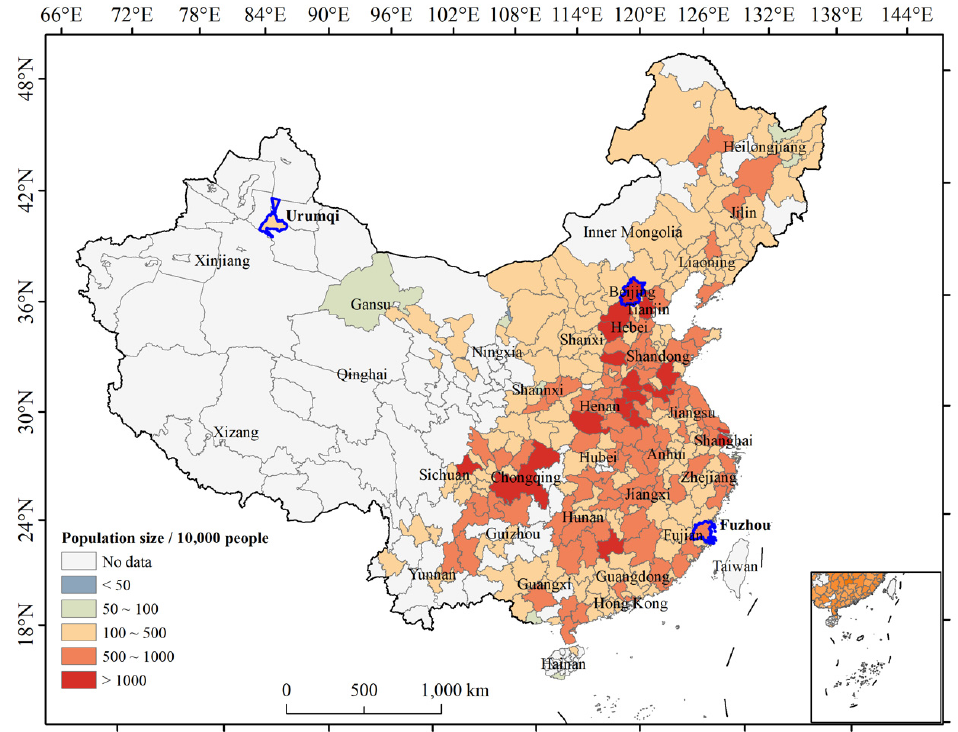
Figure 1. Population size in 267 prefectural cities in China in 2019. Note: The criteria for dividing city size by population are based on the “Notice on Adjusting the Criteria for Dividing City Size” issued by the State Council in 2014. Cities are divided into five categories. (1) Cities with a resident population of less than 500,000 in urban areas are small cities; (2) cities with a resident population of more than 500,000 and less than 1 million in urban areas are medium cities; (3) cities with a resident population of more than 1 million and less than 5 million in urban areas are large cities; (4) cities with more than 5 million and less than 10 million residents are supercities; (5) cities with more than 10 million residents are megacities.